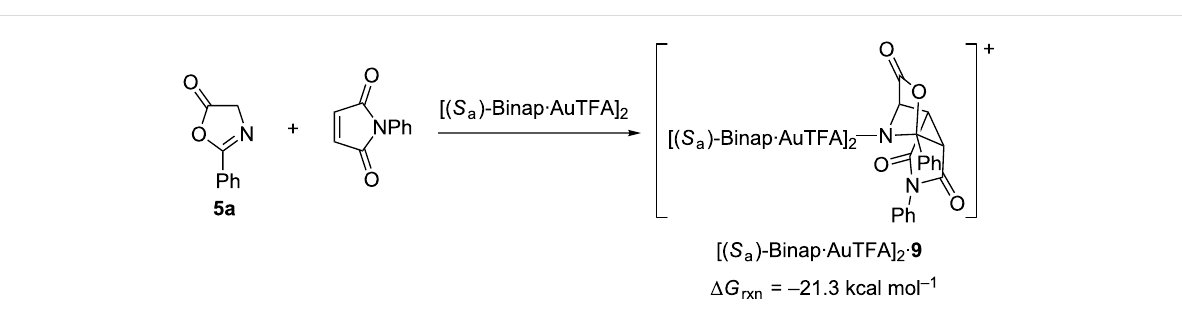
Scheme 4: Reaction Gibbs free energy associated with the 1,3-DC of 5aa and NPM catalyzed by ( S a )-Binap gold dimers computed at M06/Lanl2dz// ONIOM (b3lyp/Lanl2dz:UFF) level of